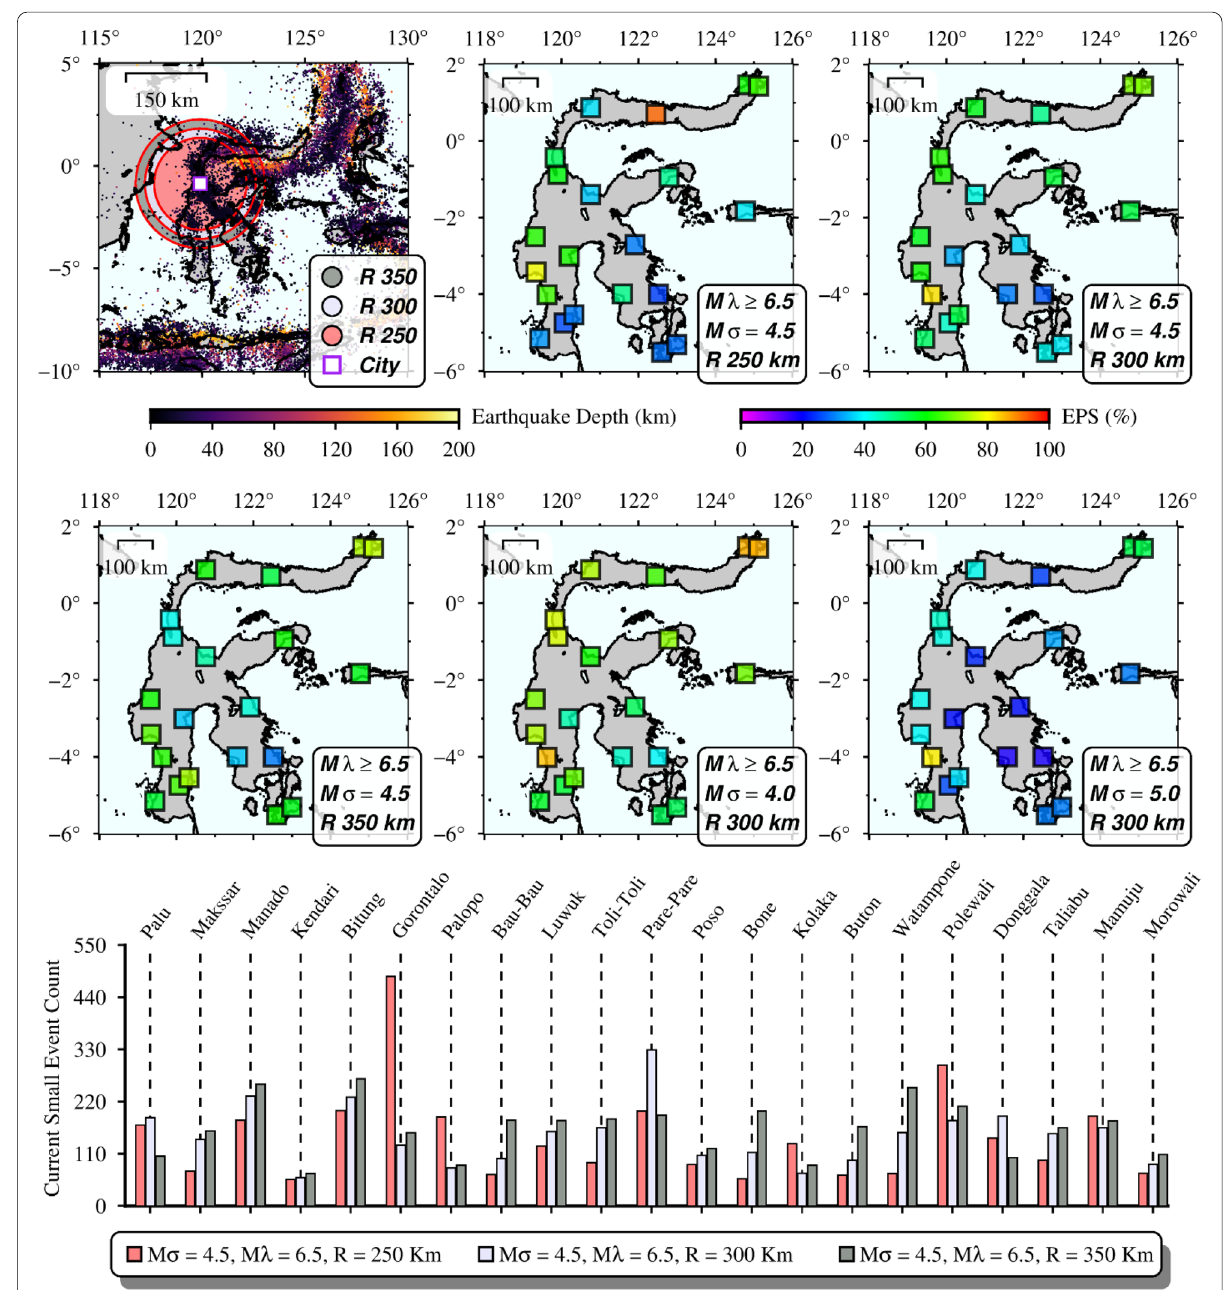
Fig. 4 Sensitivity testing of nowcast scores for different cities in Sulawesi region. The first subplot demonstrates the circular city region for the Palu city corresponding to a radius of 250 km, 300 km, and 350 km. Current number of small event counts since the last major earthquake in each circular city region are shown in the lowermost panel. These EPS values, however, bear no information of the current level of earthquake hazards due to the stationary Poissonian nature of the underlying natural-time